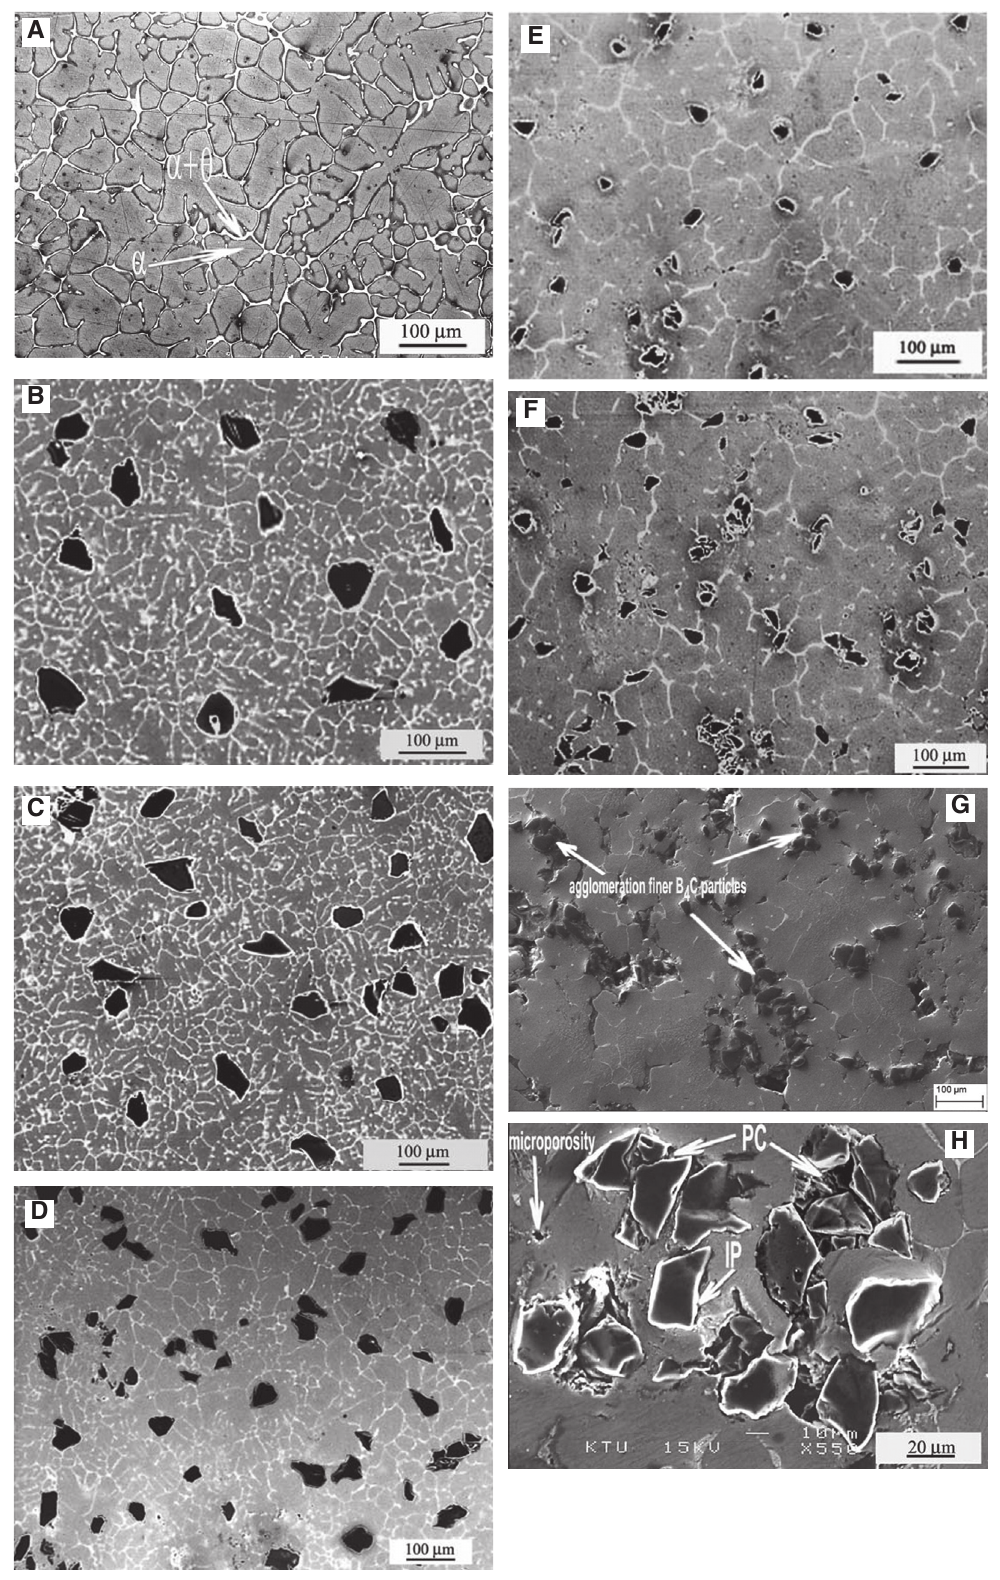
composite, (C) C composite, (D) C 3 7 C particle cluster; IP: porosity associated with the individual 4